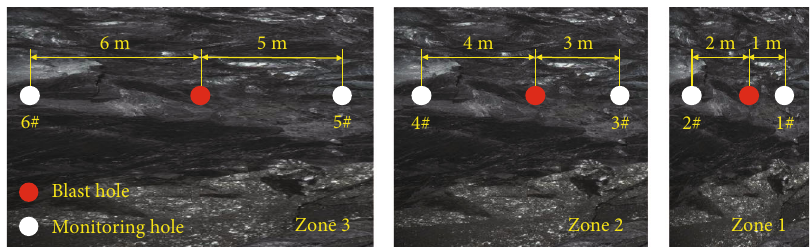
Figure 14: Schematic diagram of drilling layout.